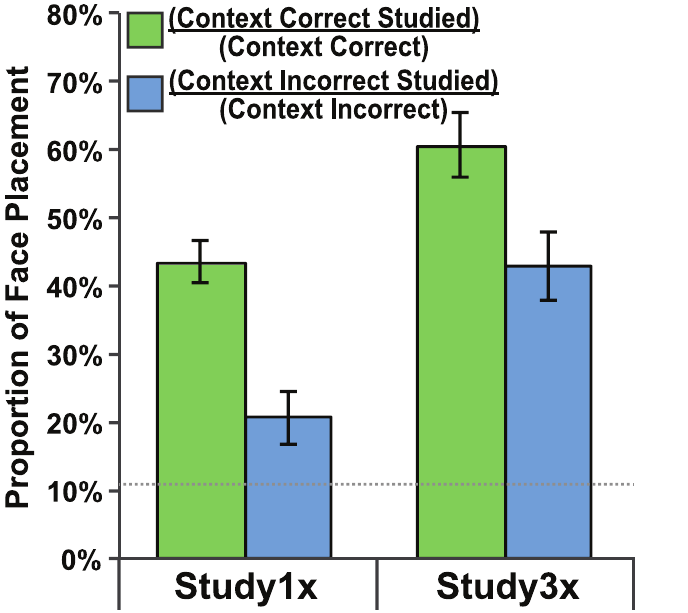
Fig 4. Studied room preference. Preference for face placements to the studied room as a proportion of all face placements to a given side of the building. Green bars indicate a preference for the studied room on the context-correct side of the building. Blue bars indicate a preference for the studied room on the context- incorrect side of the building. Data are presented for both the Study1x and Study3x groups and standard error bars are shown. The dotted gray line indicates chance-level